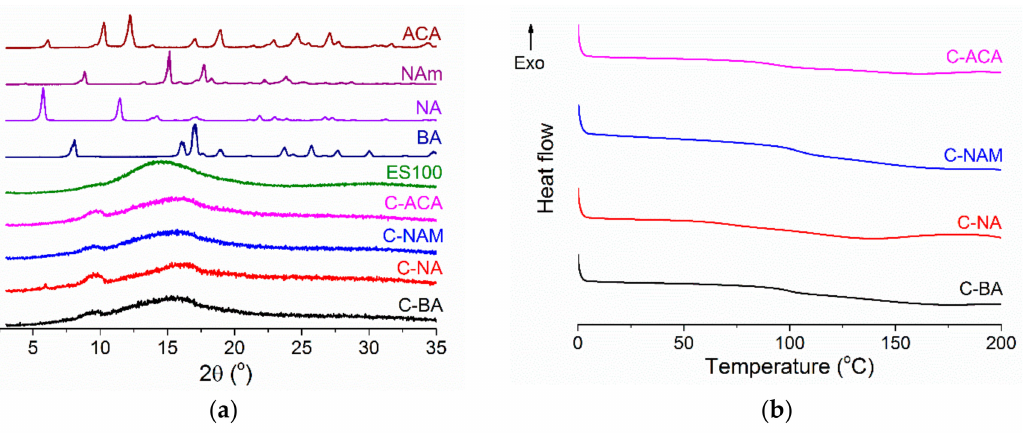
Figure 7. ( a ) XRD and ( b ) DSC data for the coaxial fibers. The data in ( a ) are normalized for ease of